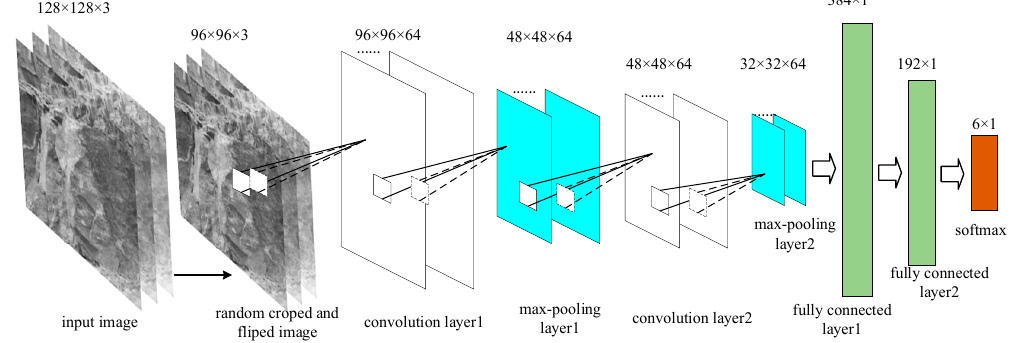
Figure 2. The Rock Types deep CNNs ( RTCNNs) model for classifying rock type in the field. Before feeding the sample images into the model, Random_Clip and Random_Flip operations are applied to the input samples. Each part of the image retains different feature of the target object.